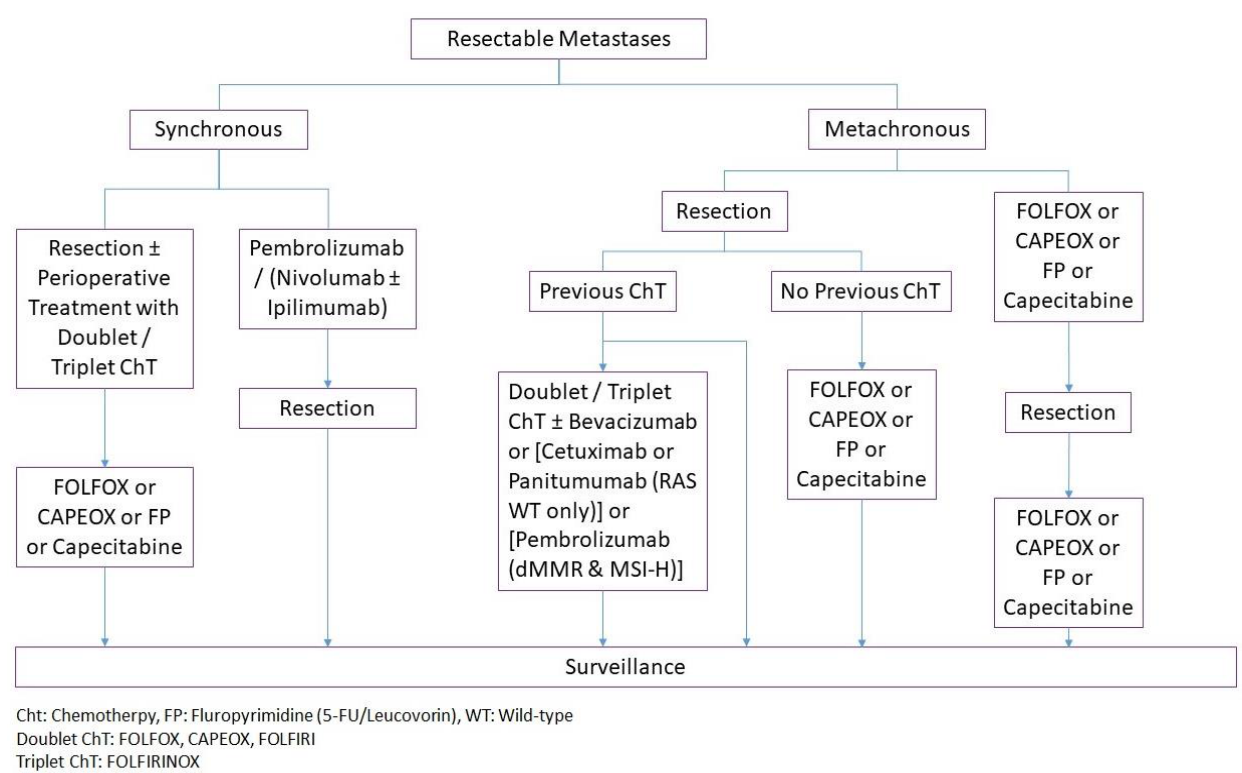
Figure 4. First-line Systemic Treatment for Stage IV CRC with Unresectable Metastases.